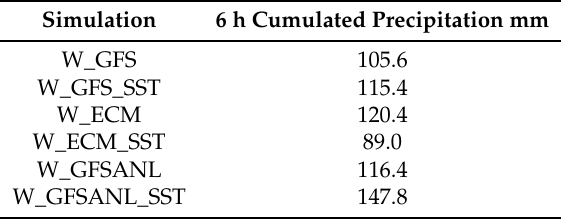
Table 2. Simulations performed in the present paper and corresponding 6 h (17 UTC–23 UTC, 3 October 2015) precipitation maxima